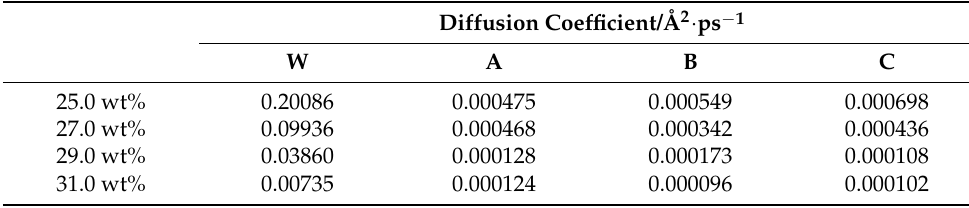
Figure 12. Mean squared displacement (MSD) curves of different components in aluminum sols at 298 K: ( a ) water molecular; ( b ) A; ( c ) B; ( d ) C. Table 3. Diffusion coefficients of different components in aluminum sol at 298 K.